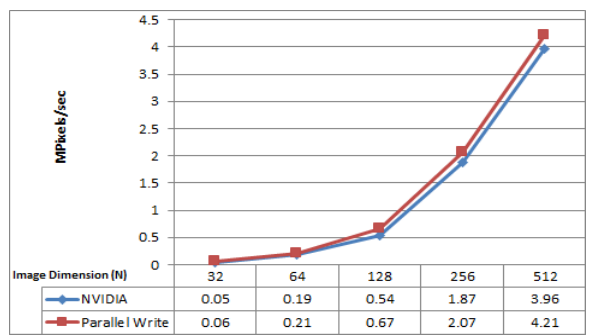
Figure 10: Performance of recursive gaussian using NVIDIA Transpose and Proposed Parallel Write al-